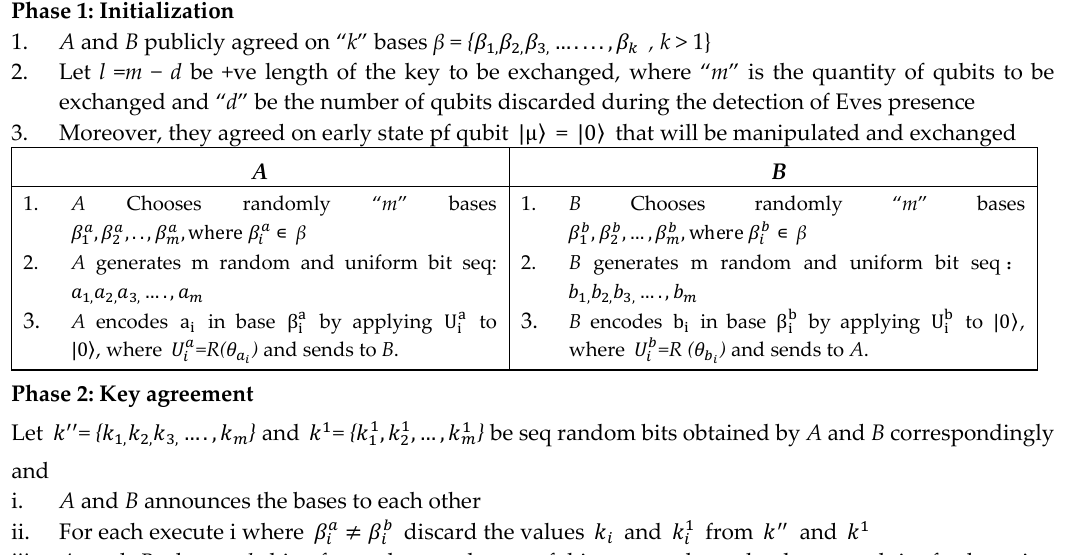
Figure 2. Two-party quantum key agreement algorithm.